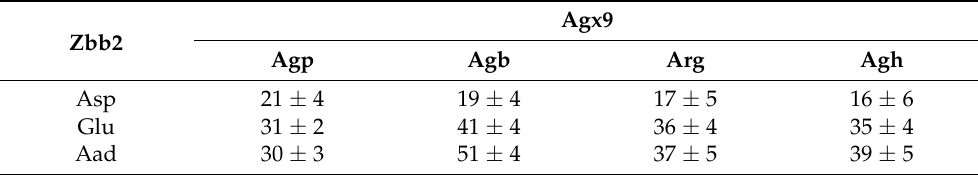
Table 1. The fraction folded population (%) for the HPDZbbAgx peptides. Zbb2